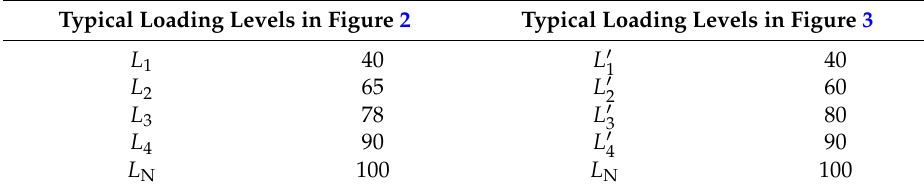
Table 1. Typical loading levels in Figures 2 and